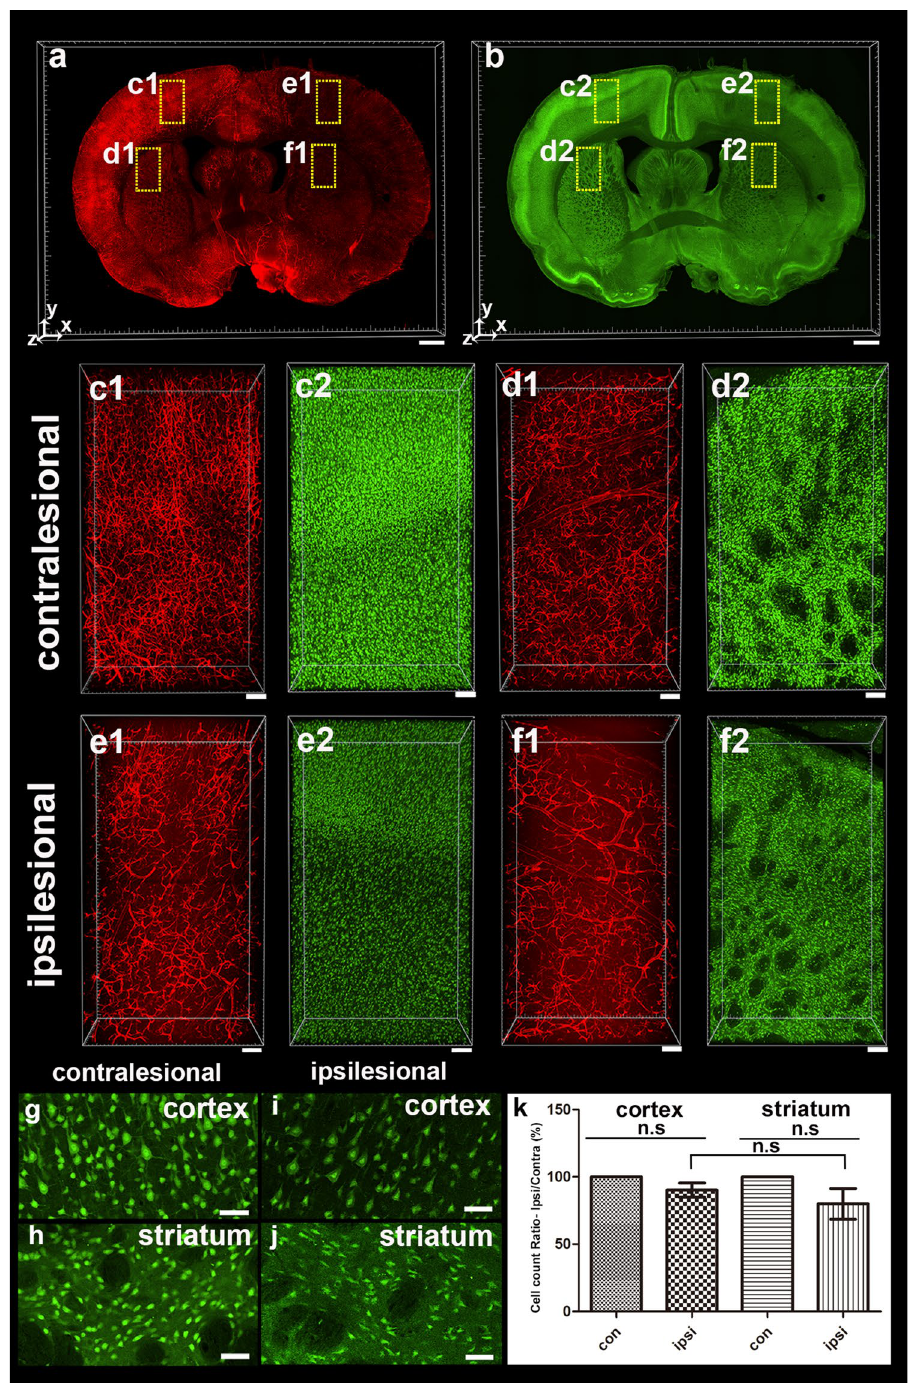
Figure 3. 3D visualization of NeuN-positive cell loss 24 h after MCAO. ( a , b ) 3D reconstruction of the 0.5-mm-thick rat brain slice stained with lectin ( a ) and NeuN ( b ). ( c – f ) Higher-magnification views of the boxed regions in ( a and b ) are shown. Vascular density loss and NeuN-positive cell loss were noted in the ipsilesional cortex and striatum compared with the contralateral side. ( g – j ) Morphological change of NeuN-positive cells in ipsilesional cortex and striatum compared with the contralateral side. ( k ) Graph of the ratio of NeuN-positive cells obtained using automated cell count in the ipsilateral areas to the corresponding contralateral areas of the cortex and striatum 24 h after ischemia using a spot detection strategy generated with Imaris v.9.5.0 software (measures 3–4 cortical and striatal fields per animal, n = 3 animals). Data are presented as the mean percentage relative to corresponding contralateral areas ± SEM. No significant differences were observed in the ratio of NeuN-positive cells between the ipsilateral cortex and the striatum. Paired t-test, FDR multiple comparison test, n.s., no significant difference. Scale bar = 1 mm in ( a , b ), 100 μm in ( c – f ) and 50 μm in ( g – j